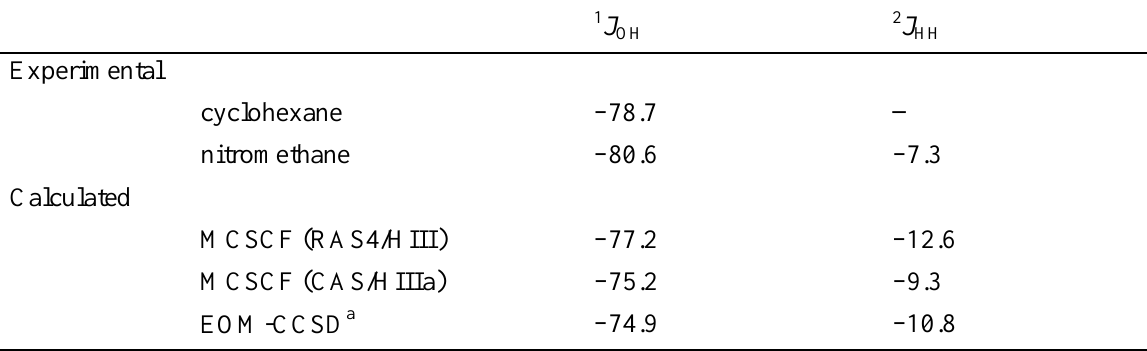
Table 1. The nuclear spin-spin coupling constants (Hz) in the water monomer